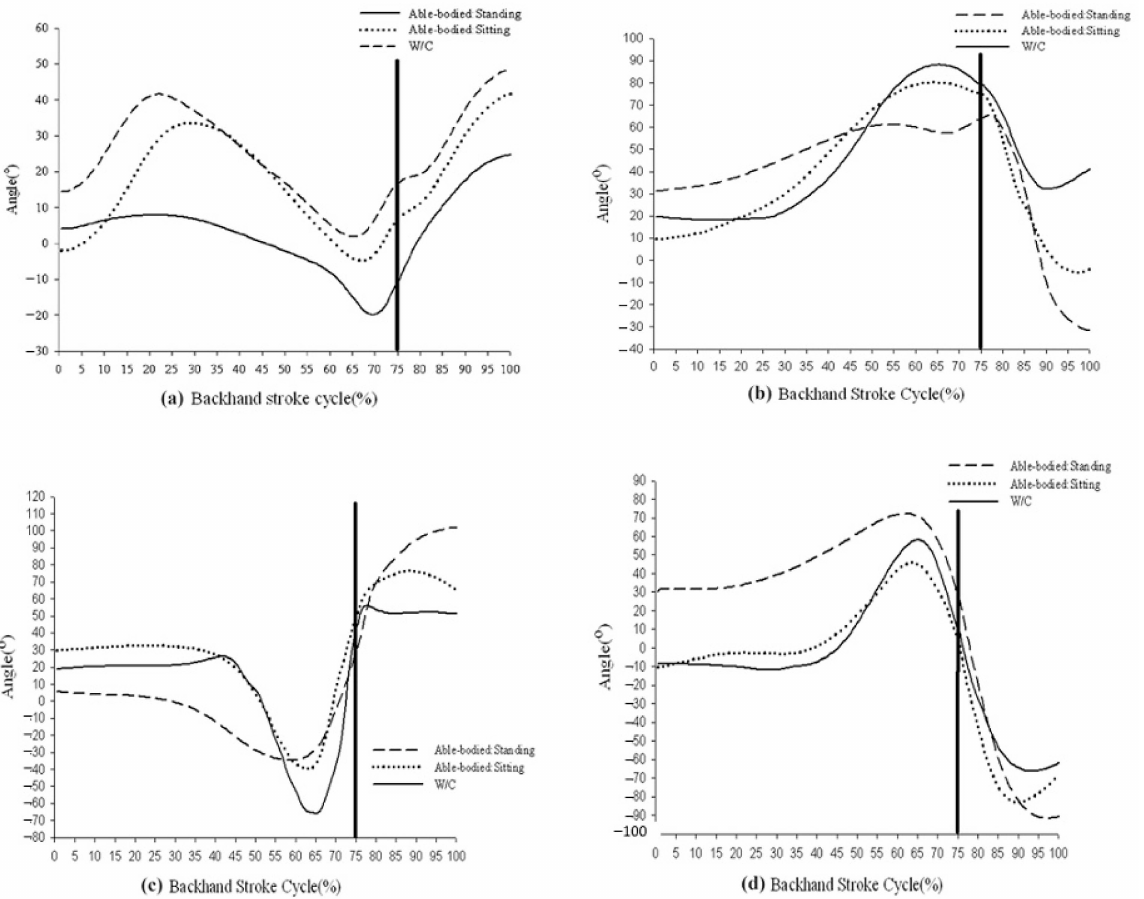
Figure 4. Movement excursions in three conditions: ( a ) trunk rotation in three conditions, ( b ) shoulder flexion/extension excursion in three conditions, ( c ) shoulder abduction/adduction excursion in three conditions, and ( d ) shoulder rotation excursion in three